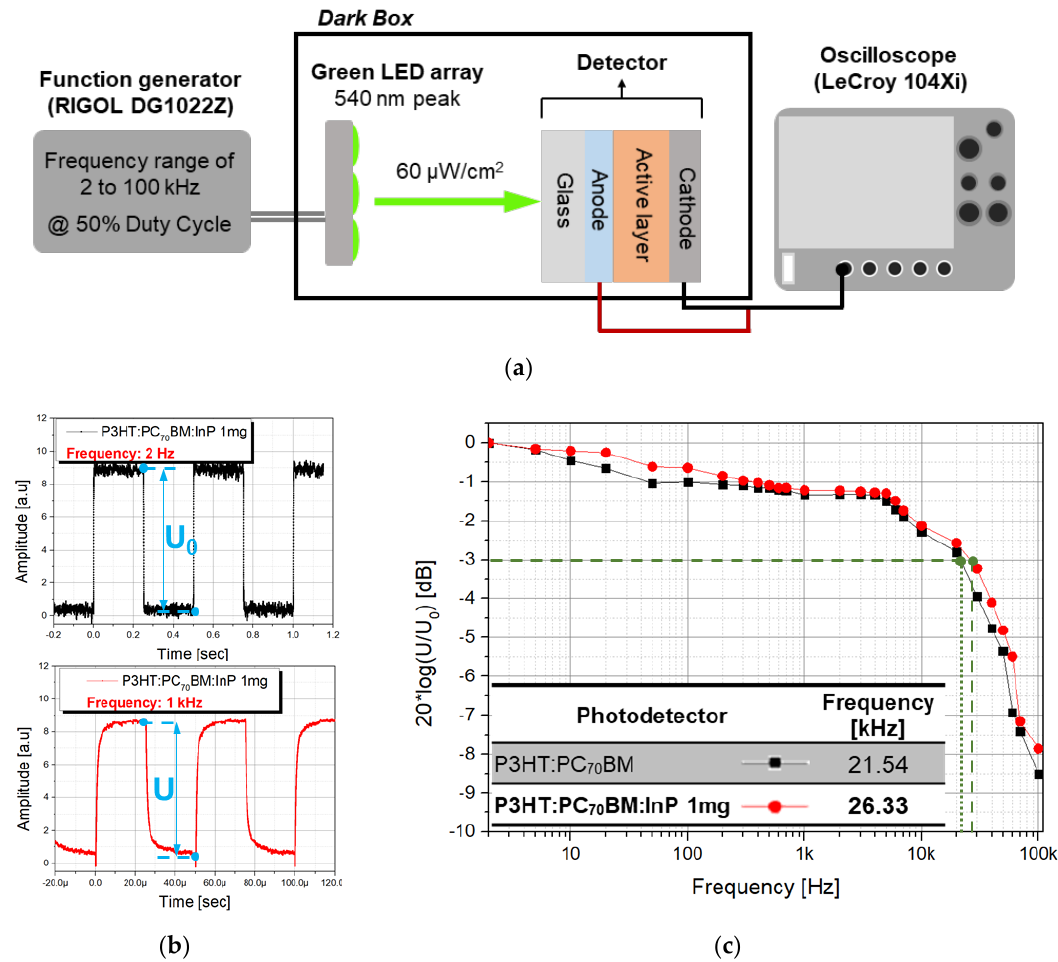
Figure 8. ( a ) Frequency response experiment setup, ( b ) square light pulse at 2 and 1 kHz, and ( c ) extracted amplitude bode plot.